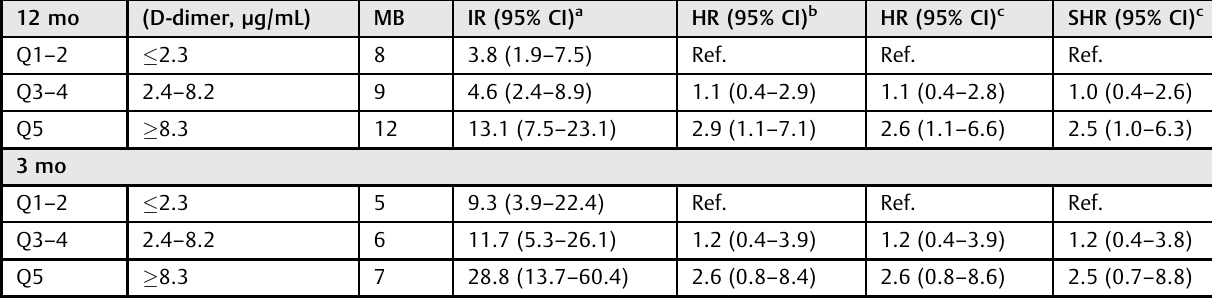
Table 3 Incidence rates (IRs) and risk of major bleeding (MB) by categories of D-dimer at 12 and 3 months of follow-up after incident venous thromboembolism